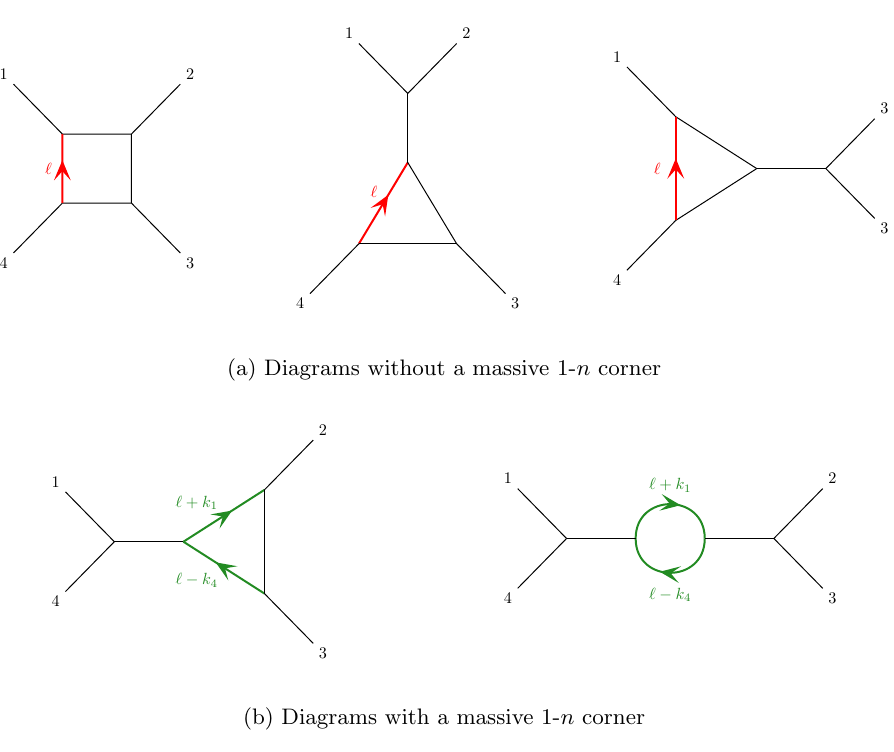
Figure 1 . The above four-particle diagrams illustrate the placement of the loop momentum ‘ between k 1 and k n =4 for planar diagrams with ordering (1234). Note that when 1 and n occur in a ‘massive corner’, there is no propagator of the form 1 =‘ 2